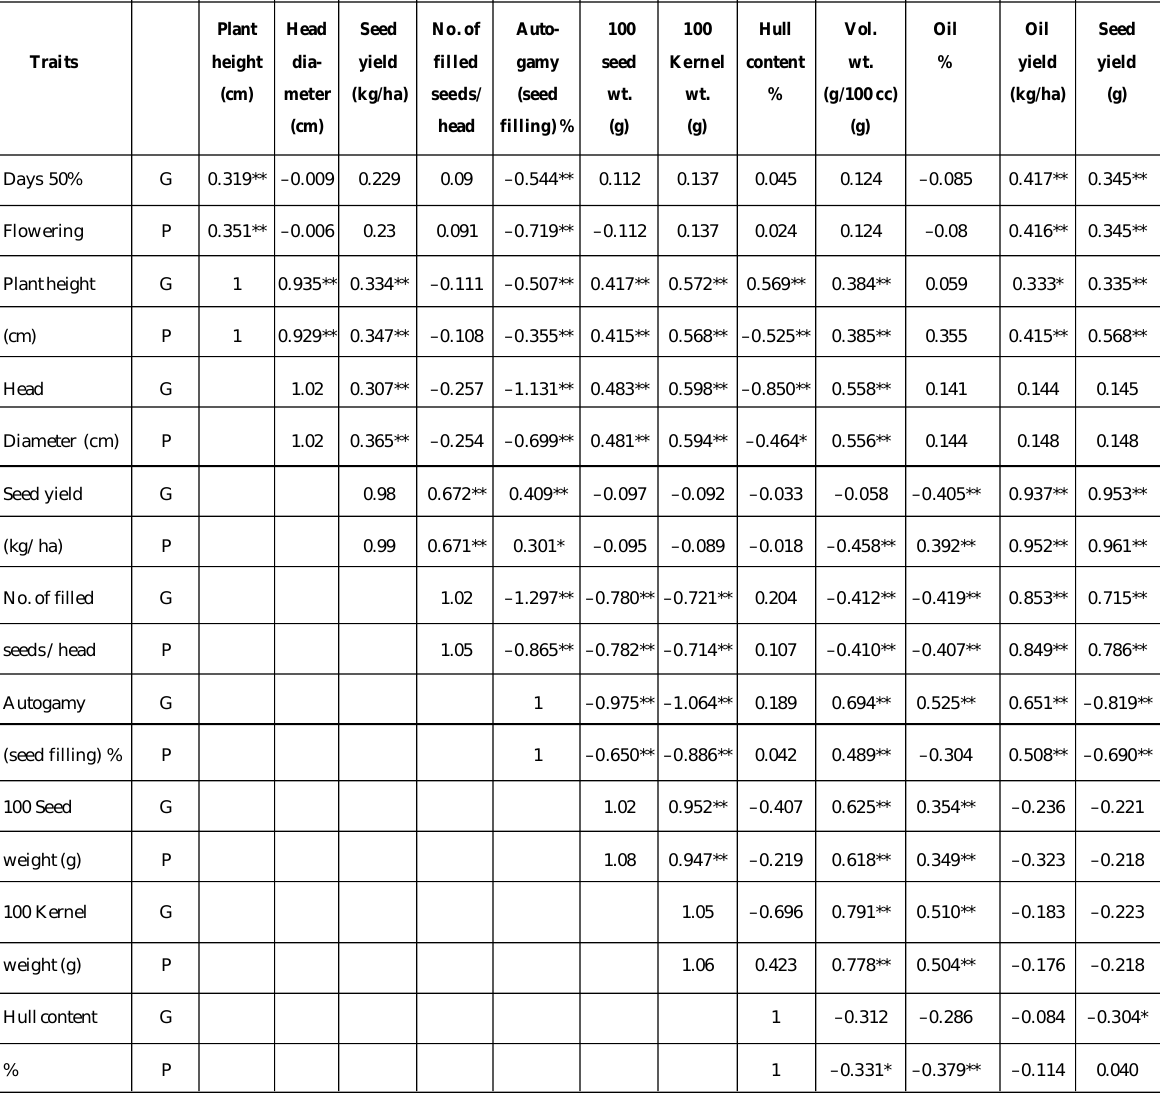
Table 4: Genotypic and phenotypic correlation coefficients among yield attributing traits Plant Head